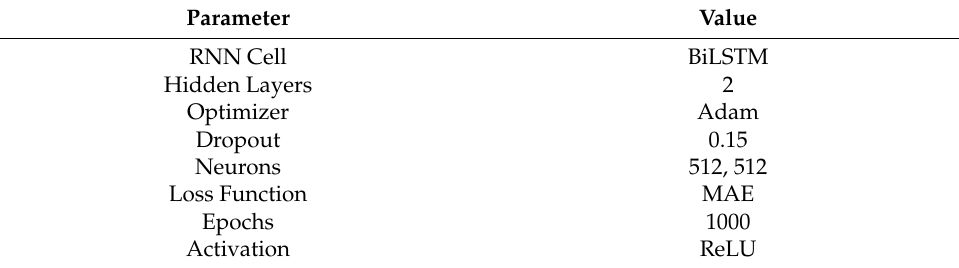
Table 5. Model Parameters used for RUL